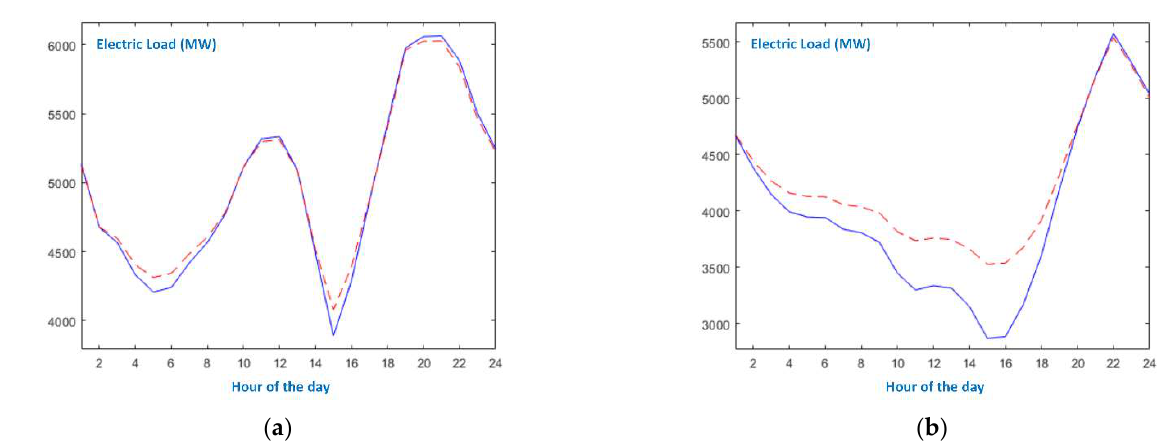
Figure 10. Presentation of holidays. The blue solid line is the actual electric load, and the red dotted line is ReNFuzz-LF’s output: ( a ) Christmas day; ( b ) Assumption day.